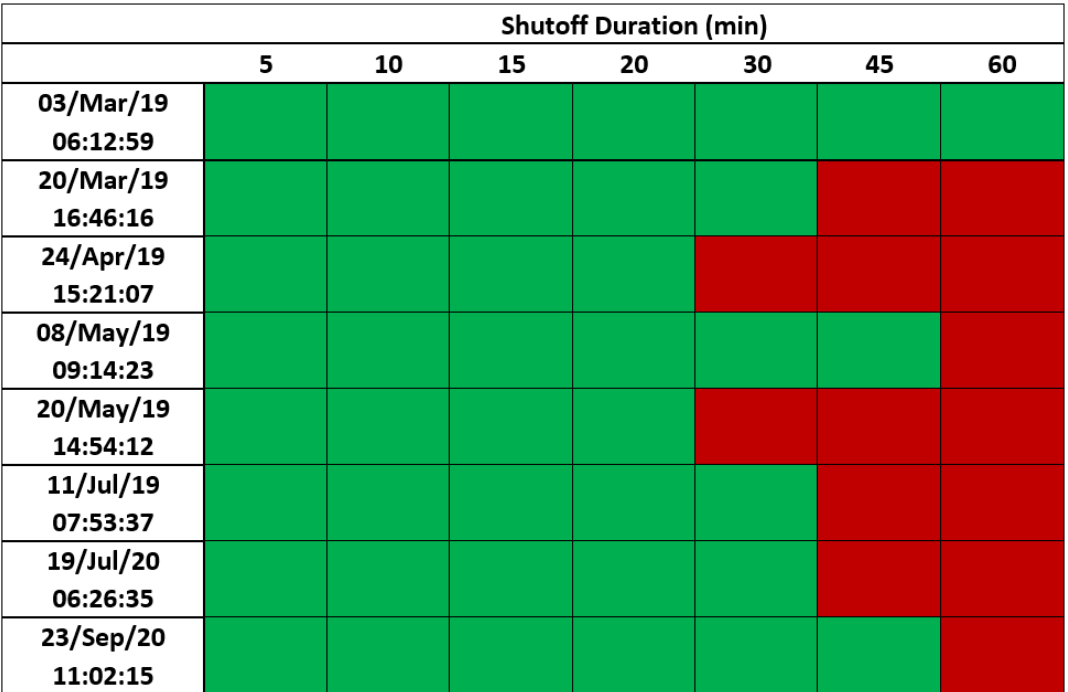
Figure 6. Overview of risk levels for each grid frequency event day and shutoff duration, with no risk represented in green and any excursion outside of allowable limits or comfort criteria causing a risk coloured in red.